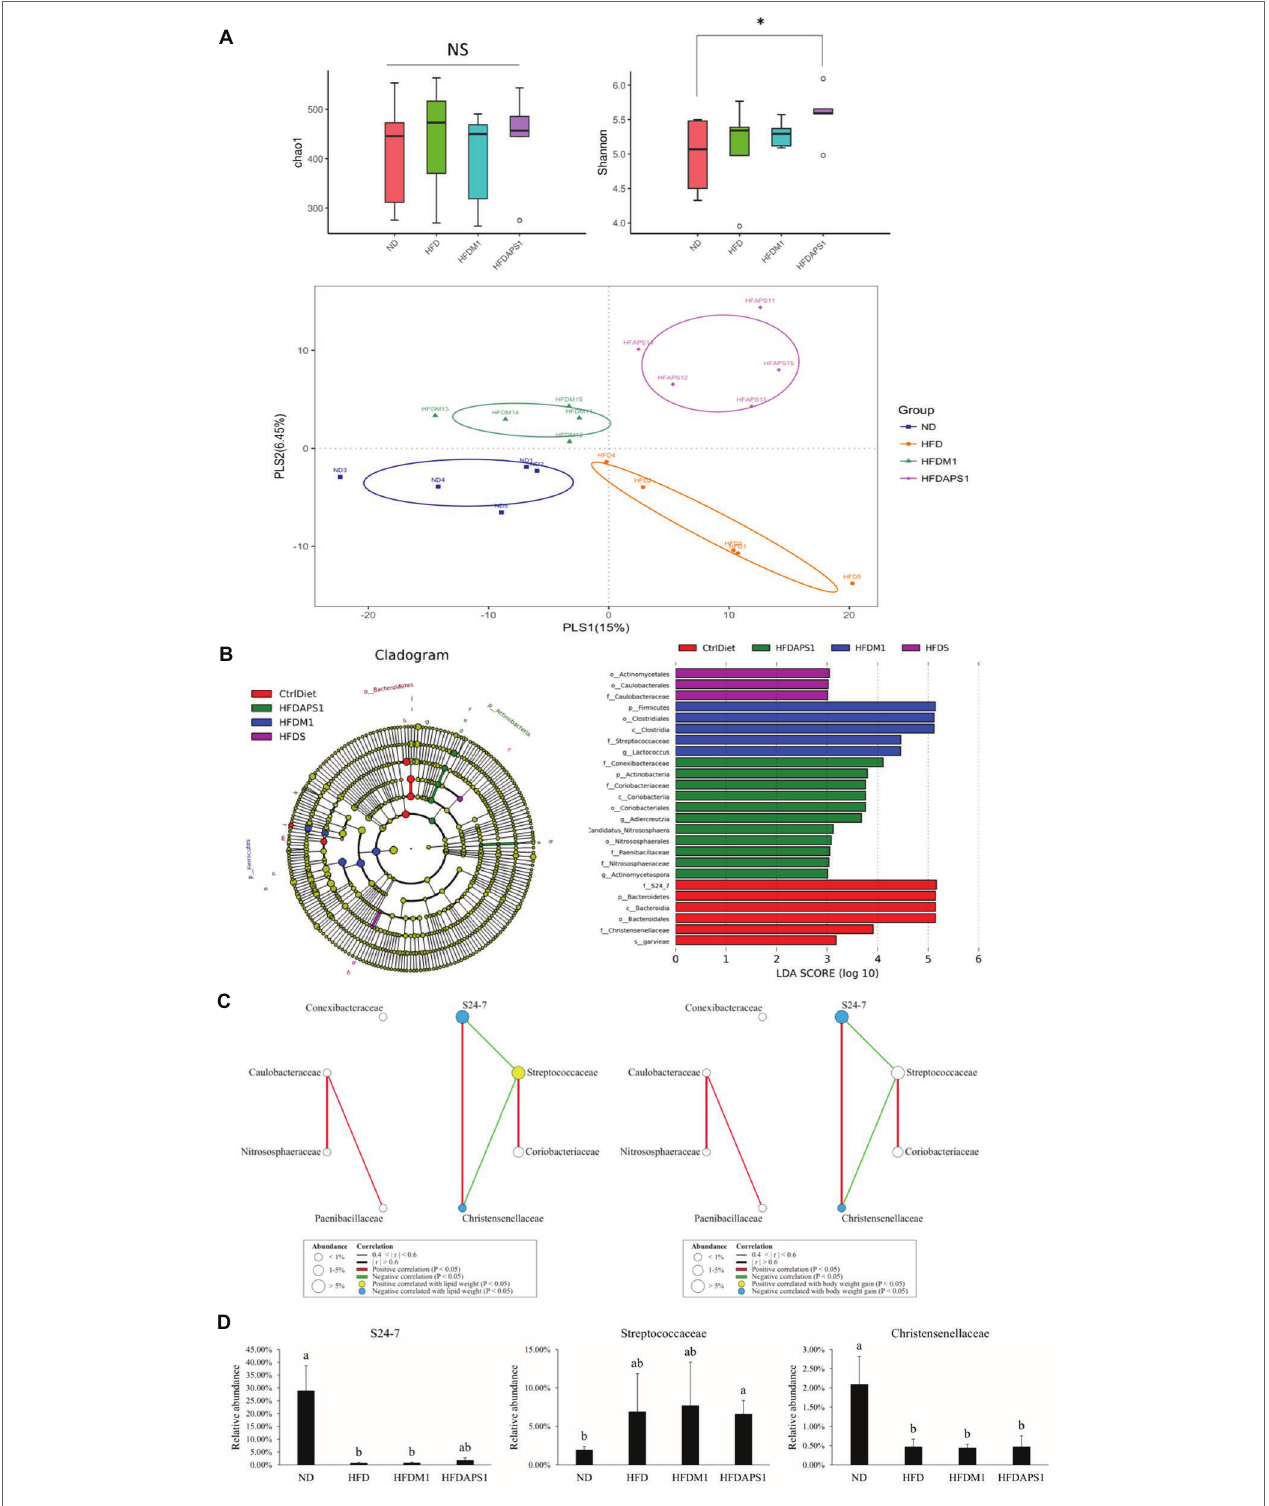
FIGURE 6 | Effects of M1 and APS1 on manipulation of gut microbiota. (A) Alpha diversity of Chao1 richness index and Shannon’s diversity index and beta- diversity of supervised partial least squares-discriminant analysis (PLS-DA); (B) taxonomic cladograms derived from linear discriminant analysis effect size (LEfSe) analysis; bacterial networks co-occurring families of taxonomic cladograms correlating with (C) lipid weight and body weight gain; and (D) the relative abundance